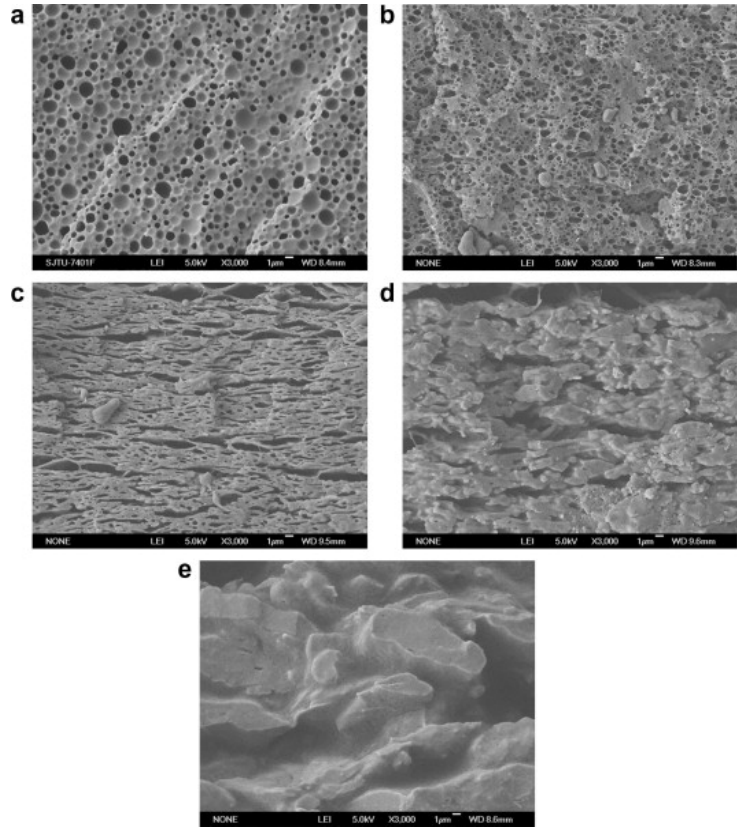
Figure 4. SEM images of poly(2,6-dimethyl-1,4-phenylene oxide)/polyamide (PdMPO/PA6) (50/50 phr/phr)-based polymer nanocomposites containing ( a ) 0 phr POSS, ( b ) 2 phr POSS, ( c ) 4 phr POSS, ( d ) 6 phr POSS and ( e ) 8 phr POSS. (“phr” stands for parts per 100 parts of resin.) Reproduced with permission from Li et al . [67].